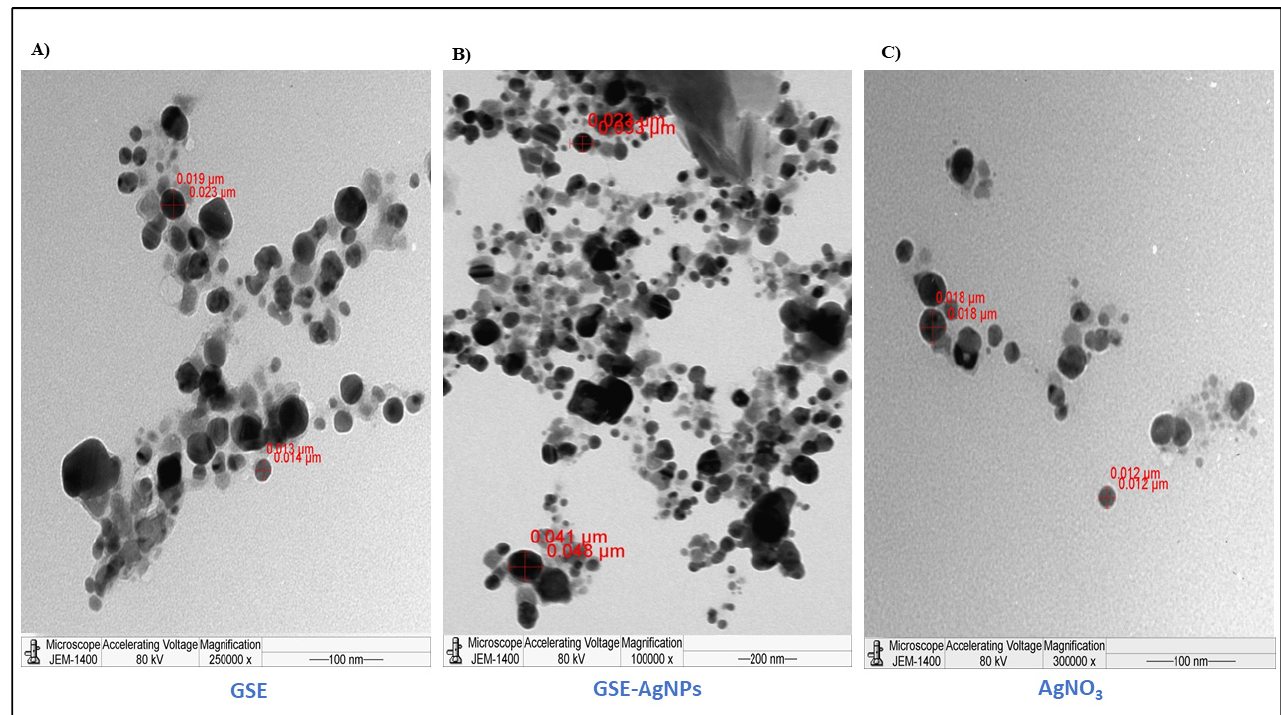
Figure 4. The TEM imaging of GSE-AgNPs . JEM-1011 transmission electron microscope was used to investigate the crystalline structure of ( A ) GSE, ( B ) GSE-AgNPs, and ( C ) AgNO 3 . The diameter sizes of the tested materials were measured by ImageJ software.